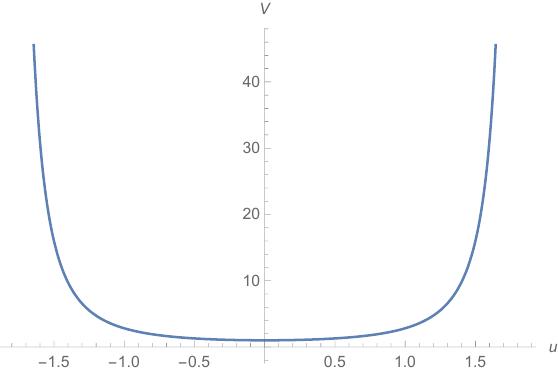
Figure 5 . The potential 1 = cn 2 u for one period of elliptic functions. The coordinates are such that we are inside one period and the two AdS boundaries are where the potential blows